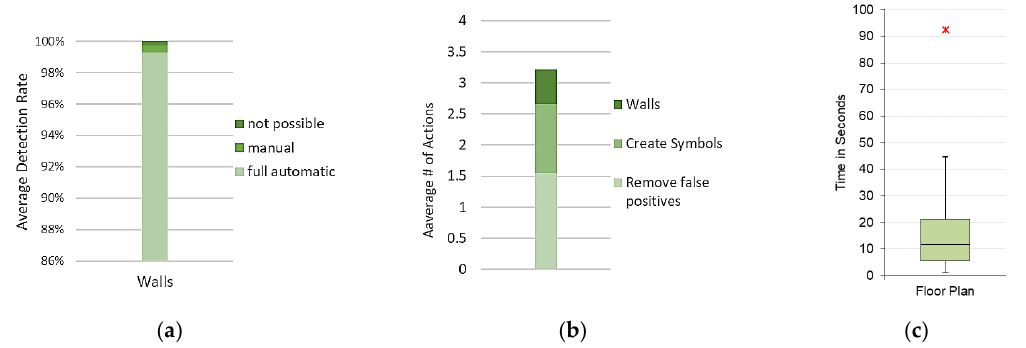
Figure 19. ( a ) The detection rate of all wall elements over all analyzed floor plans. ( b ) Average necessary interactions in order to complete the floor plan. ( c ) Time needed to complete the automated detection process of a floor plan.